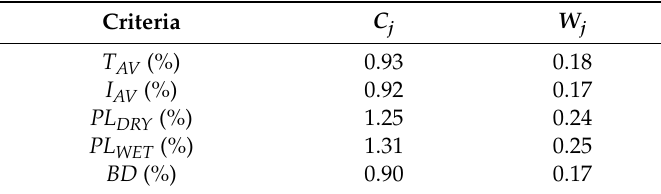
Table 10. Weights of the di ff erent response